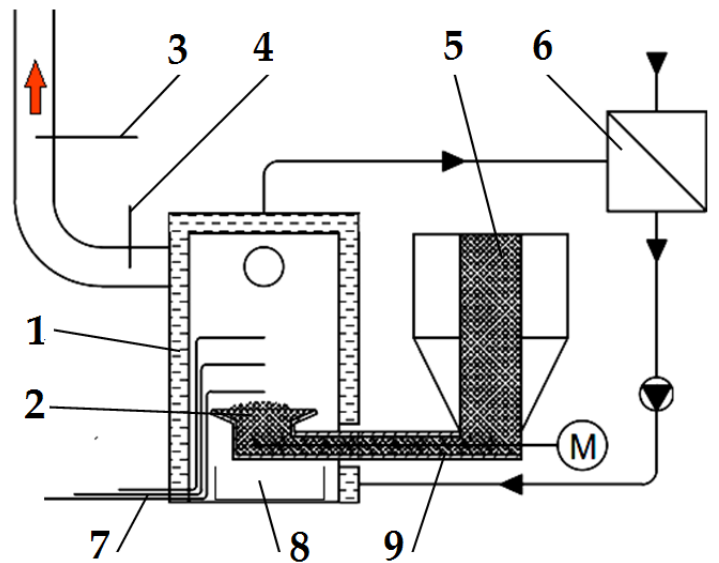
Figure 2. Schematic diagram of the emission measurement test bench: (1) boiler, (2) retort burner, (3) flue gas analyser probe, (4) thermocouple for measuring flue gas temperature, (5) fuel dosing line, (6) heat exchanger, (7) thermocouples for measuring flame temperature, (8) ash container, and (9) screw conveyor. Red arrow—flue gas, M—screw conveyor motor.